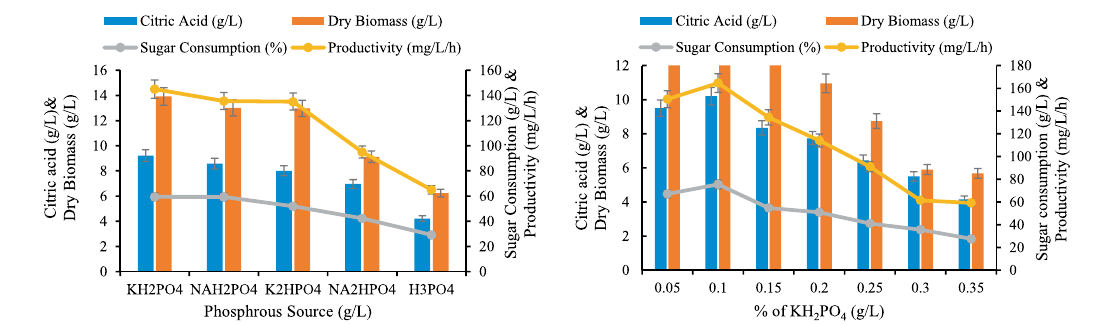
PO on citric acid 2 4